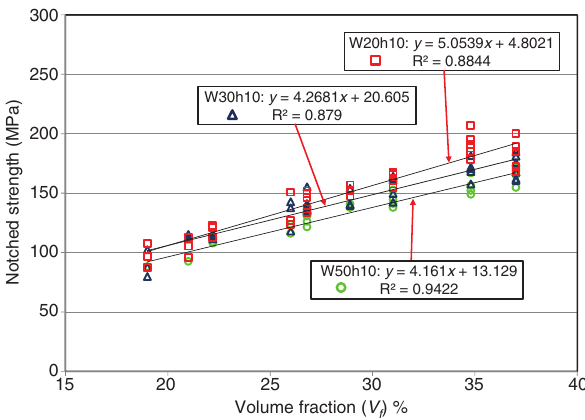
Figure 4 Tensile test result of notched specimens.